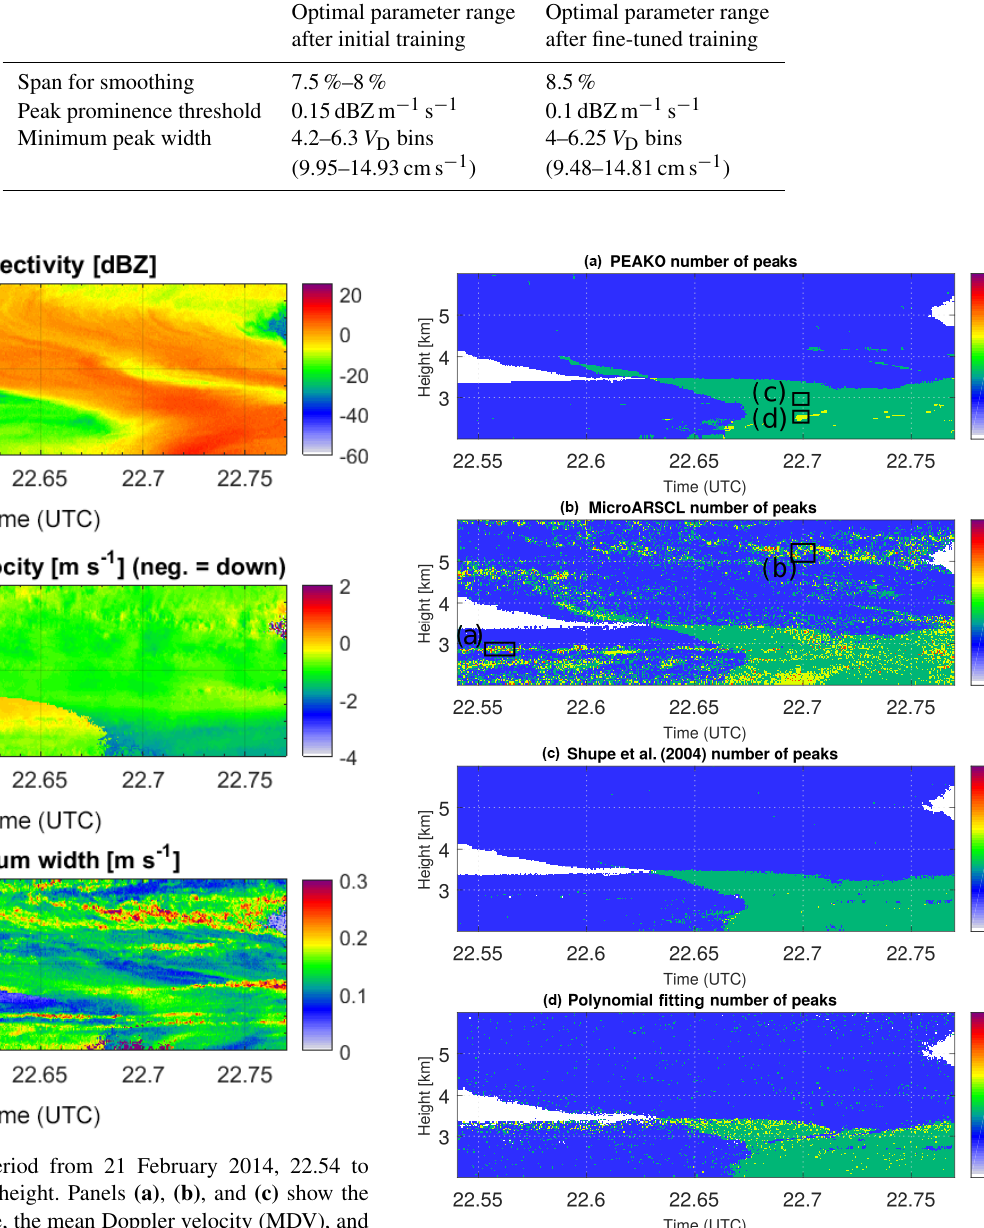
algorithms for the selected case study on 21 February 2019 from 22.54 to 22.77UTC at 2 to 6km altitude. (a–d) Number of peaks found by the PEAKO algorithm for one of the “best parameter” combinations obtained in the training phase of the algorithm; num- ber of peaks in MicroARSCL data product; number of peaks de- tected using the criteria of Shupe_04; number of peaks determined by